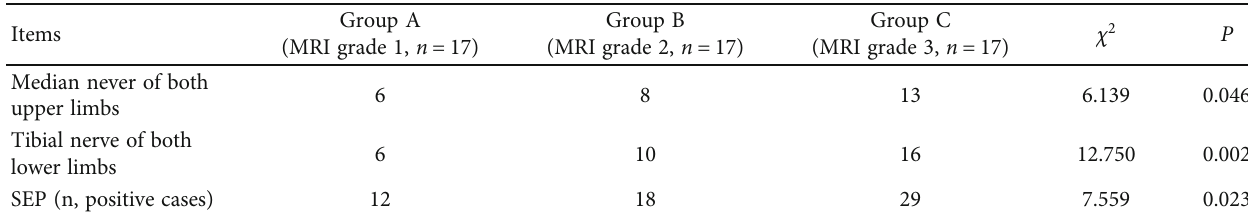
Table 3: Comparison of detection results of SEP examination.